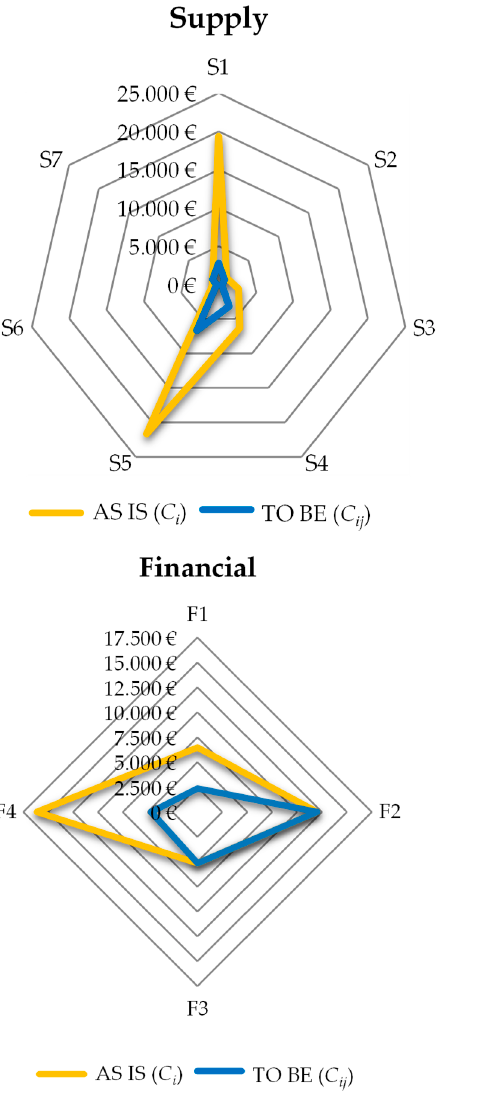
Figure 4. AS IS and TO BE models in terms of in terms of expected annual cost ( € ) for supply (S), environment (ET), financials (F) and legislation (L) aspects.